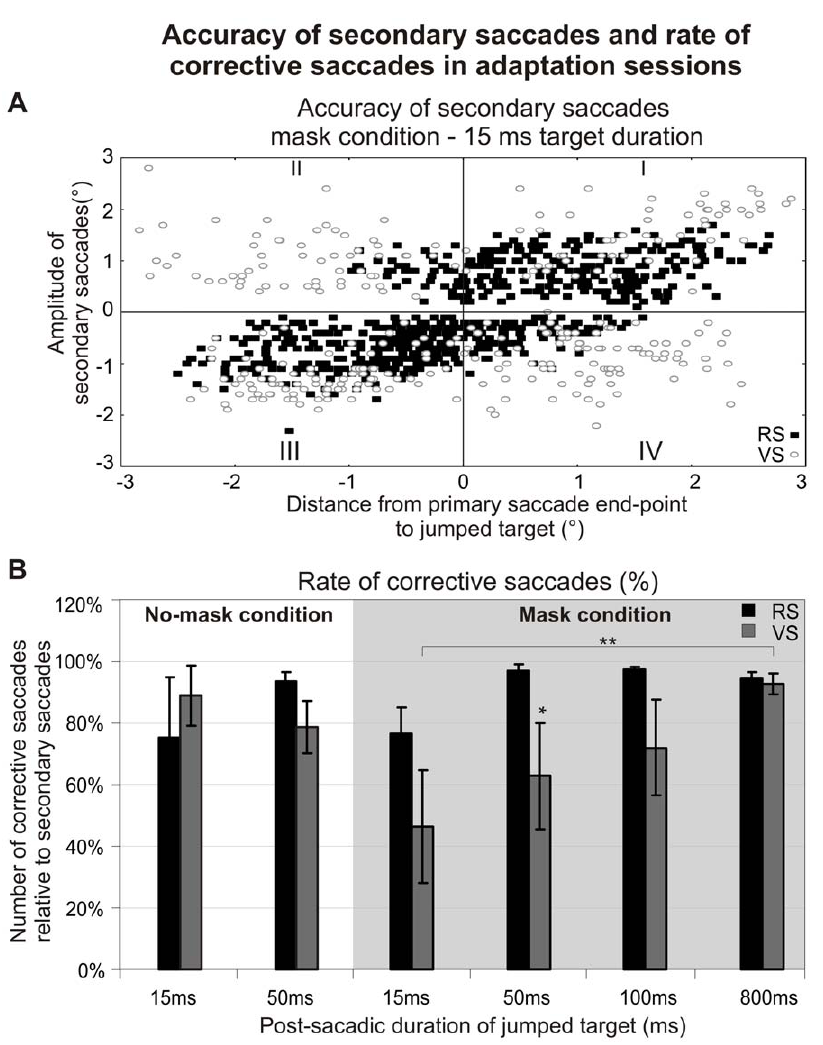
Figure 5. Accuracy of secondary saccades and rate of corrective saccades in adaptation sessions. (A) Amplitude of secondary saccades represented as a function of distance from primary saccade endpoint to jumped target. In this example, the secondary saccades were measured in the adaptation sessions of reactive ( & ) and of voluntary (o) saccades in the mask condition, for the target duration of 15 ms. Secondary corrective saccades are located in quadrants I and III, corresponding to secondary saccades with positive (negative) amplitude when the jumped target was located in the right (left) visual field. (B) Rate of corrective saccades relative to the total number of secondary saccades measured during the adaptation sessions of reactive (black bars) and voluntary (grey bars) saccades. The mean rate of corrective saccades was calculated across the 5 subjects of each experimental session and is represented as a function of the target durations (15, 50, 100 and 800 ms) for the mask (grey background) and the no-mask (white background) conditions. Error bars are SEMs. Significant differences of gain changes between the saccade categories and target durations are indicated by * (p , 0.05), ** (p , 0.01).